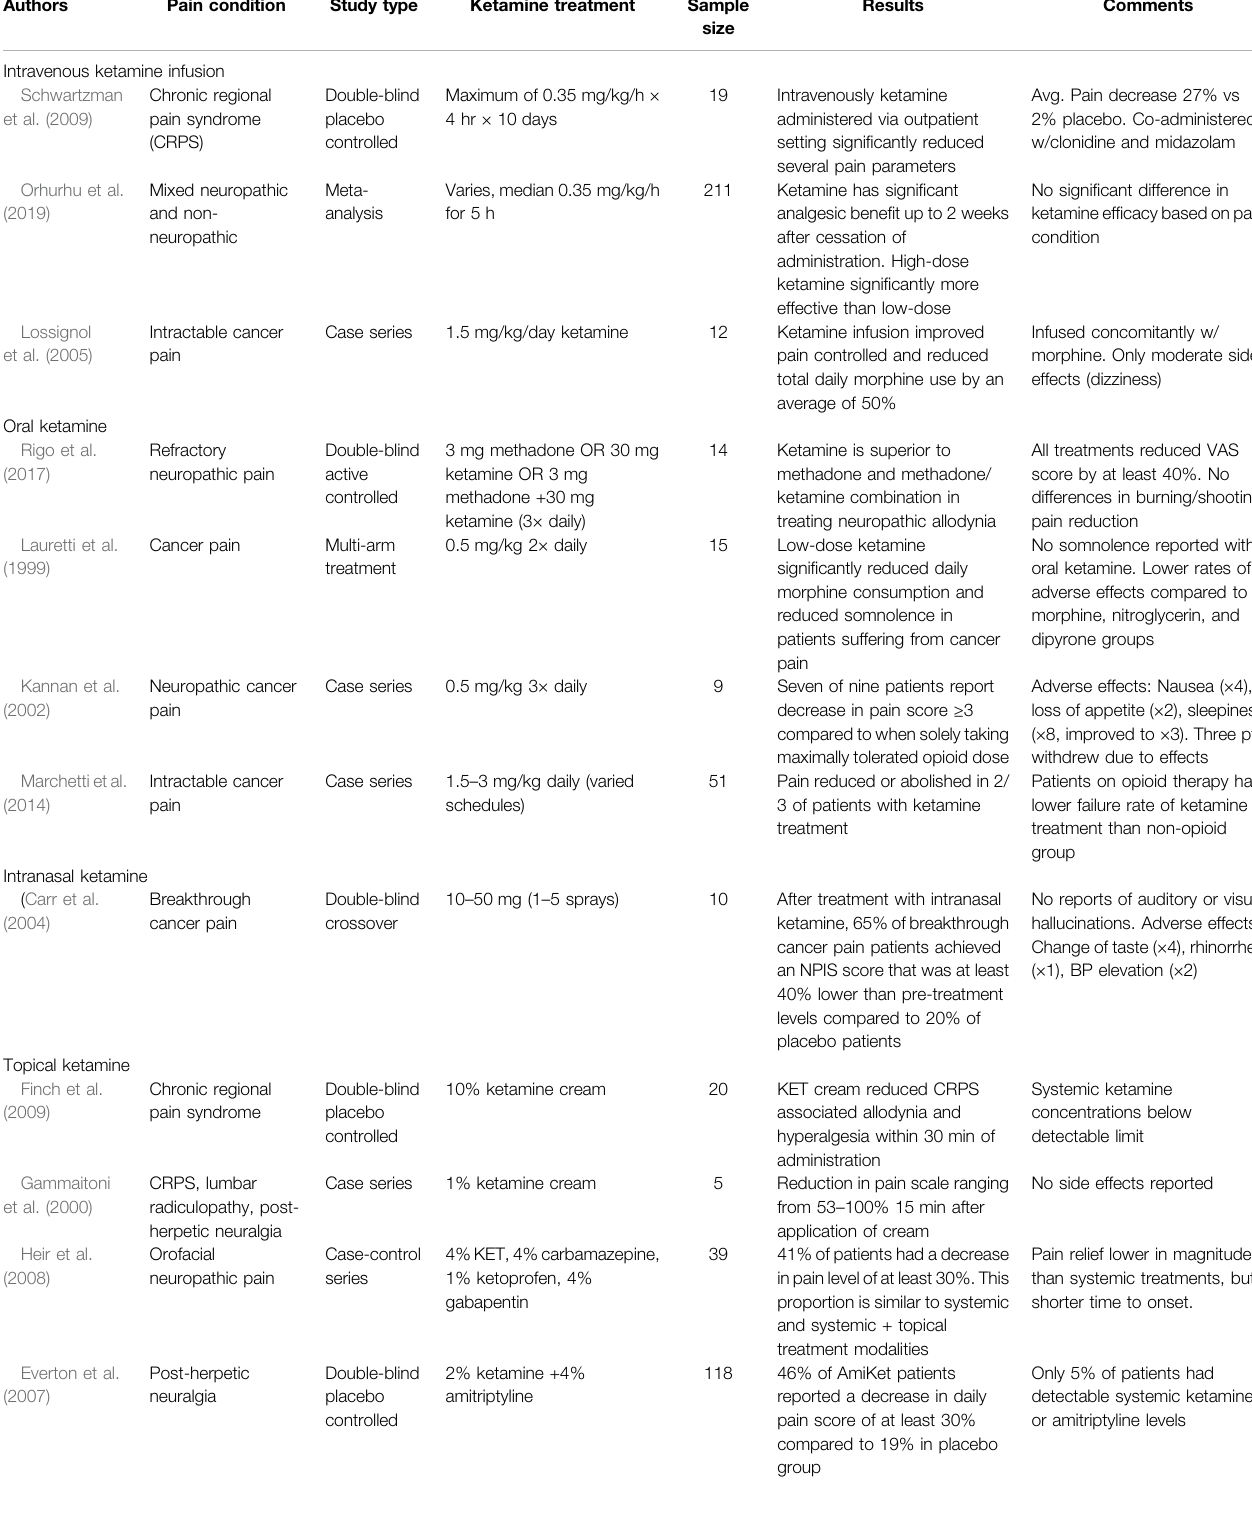
TABLE 2 | Compiled clinical evidence supporting ketamine ’ s analgesic